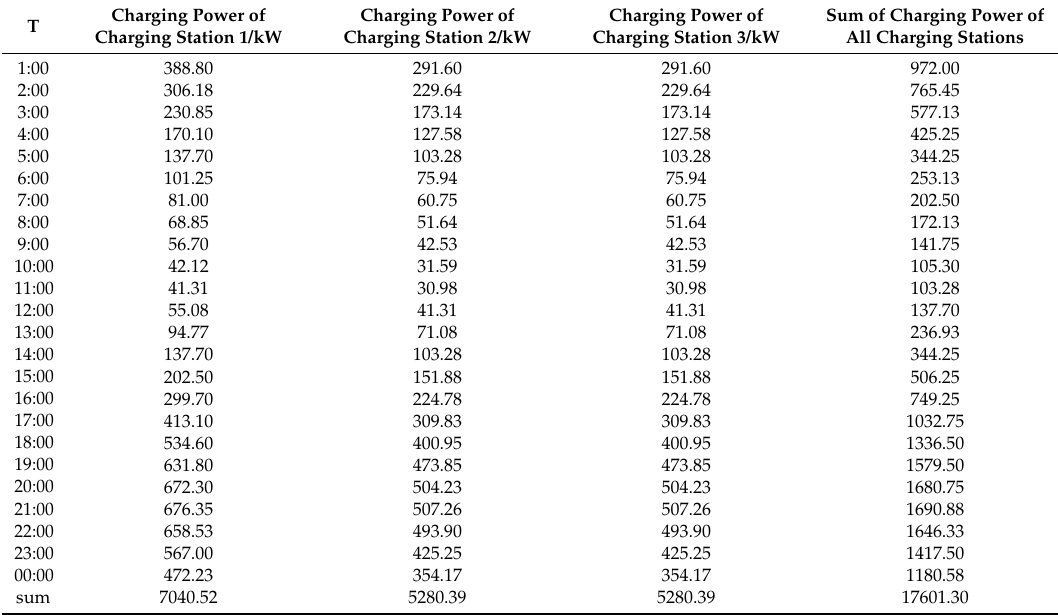
Table A1. Charging power of each charging station at different periods in EV free charging mode.